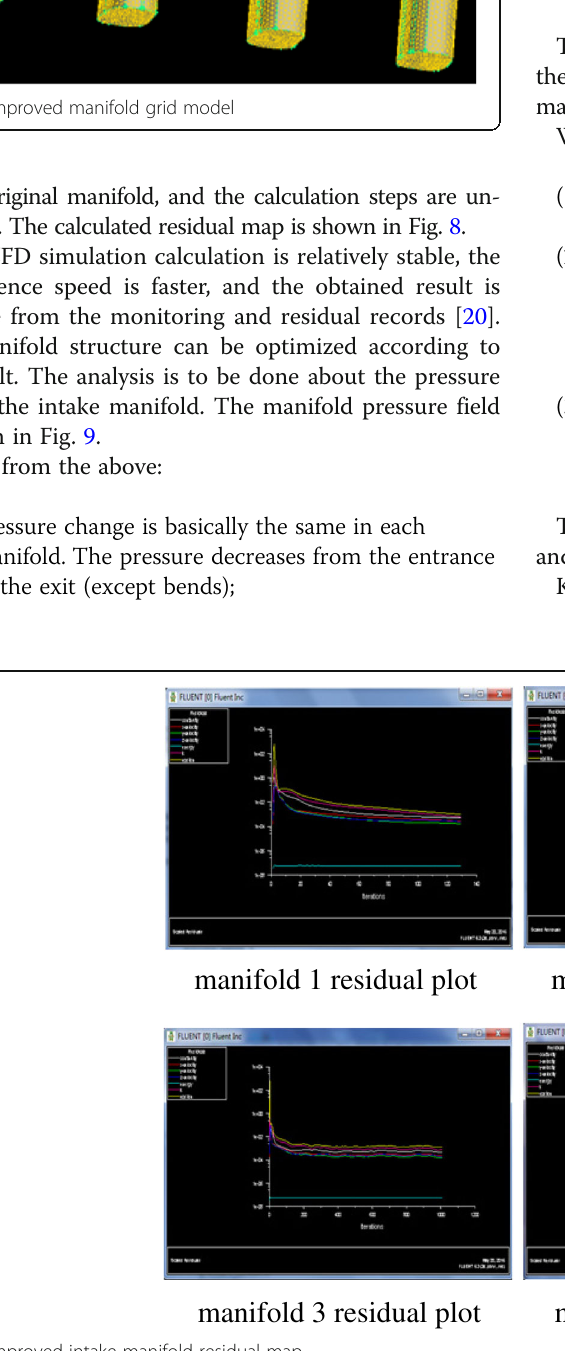
Fig. 8 Improved intake manifold residual map